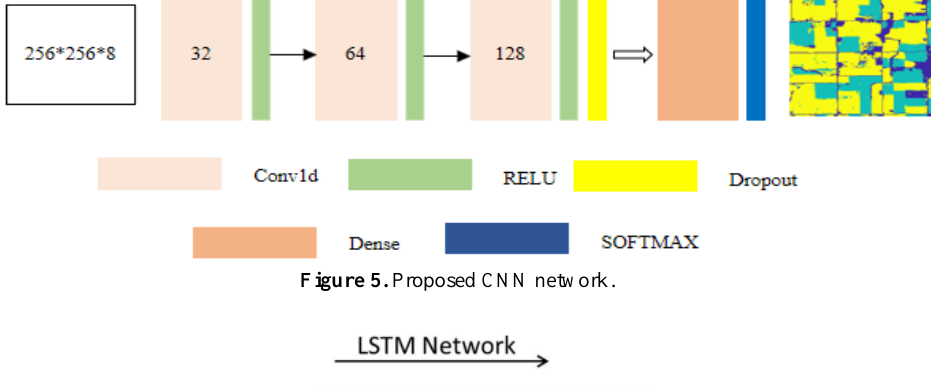
Figure 5. Proposed CNN network.